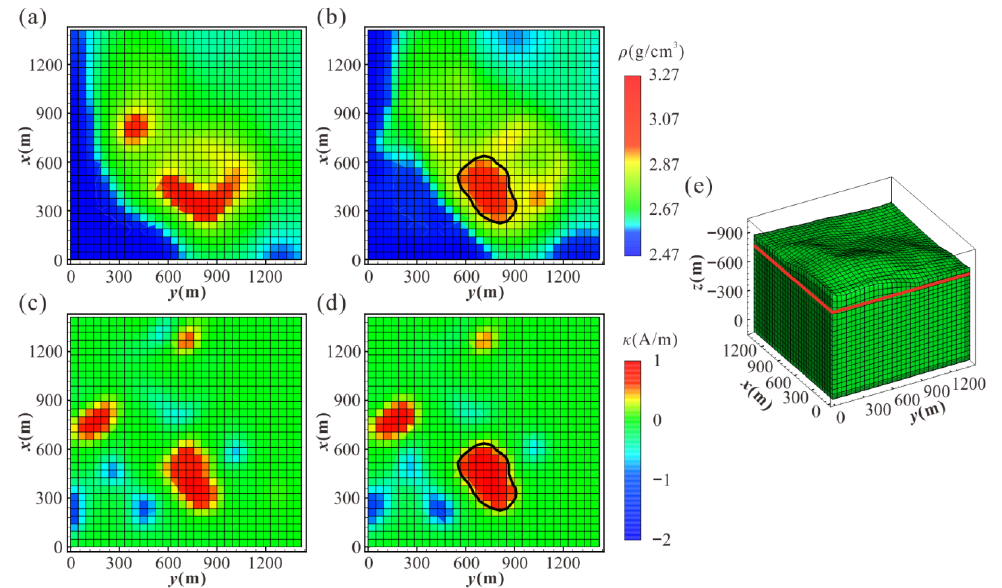
Figure 22. Slice of density (up) and magnetization (down) at z = −780 m. ( a , c ) Separate result; ( b , d ) joint result; ( e ) trace of slice.